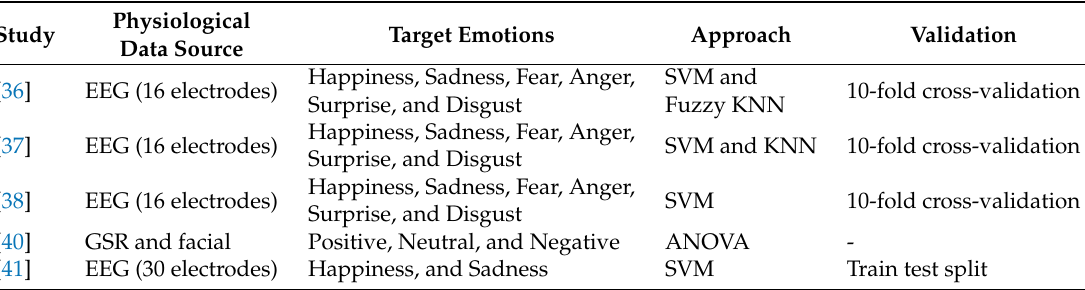
Table 3. Studies on participants with neurological